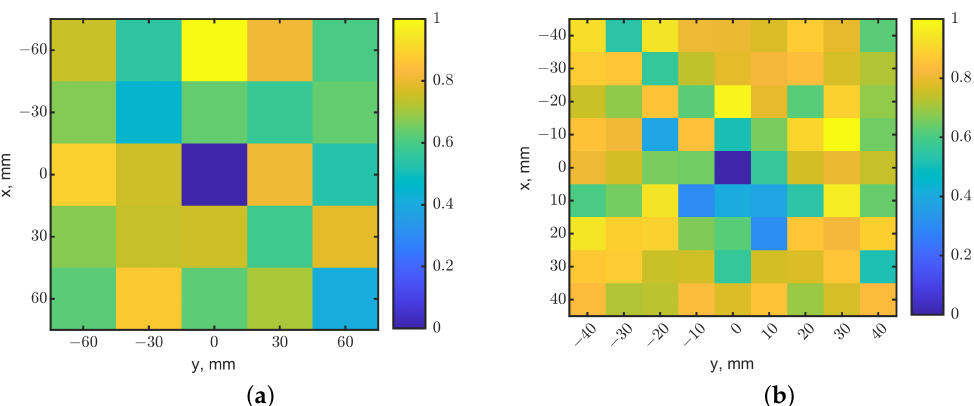
Figure 19. Comparison of heatmaps by the tuned phased loop array with different raster step sizes of ( a ) 30 and ( b ) 10 mm. The tumor was placed in (0, 0) at a depth of 25 mm and had a smaller size of 10 3 mm 3 . The dark-blue pixels indicate the tumor’s